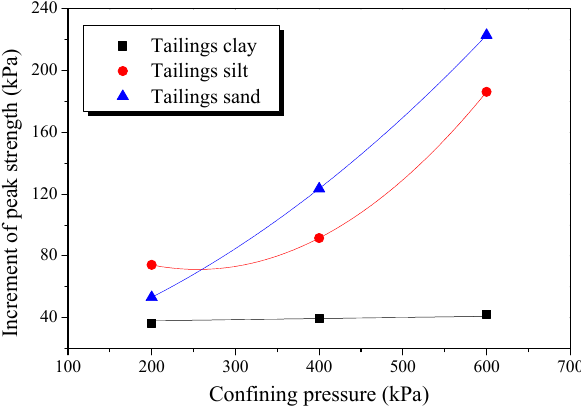
Figure 16. Increment of the peak strength of reinforced tailings under different confining pressure.